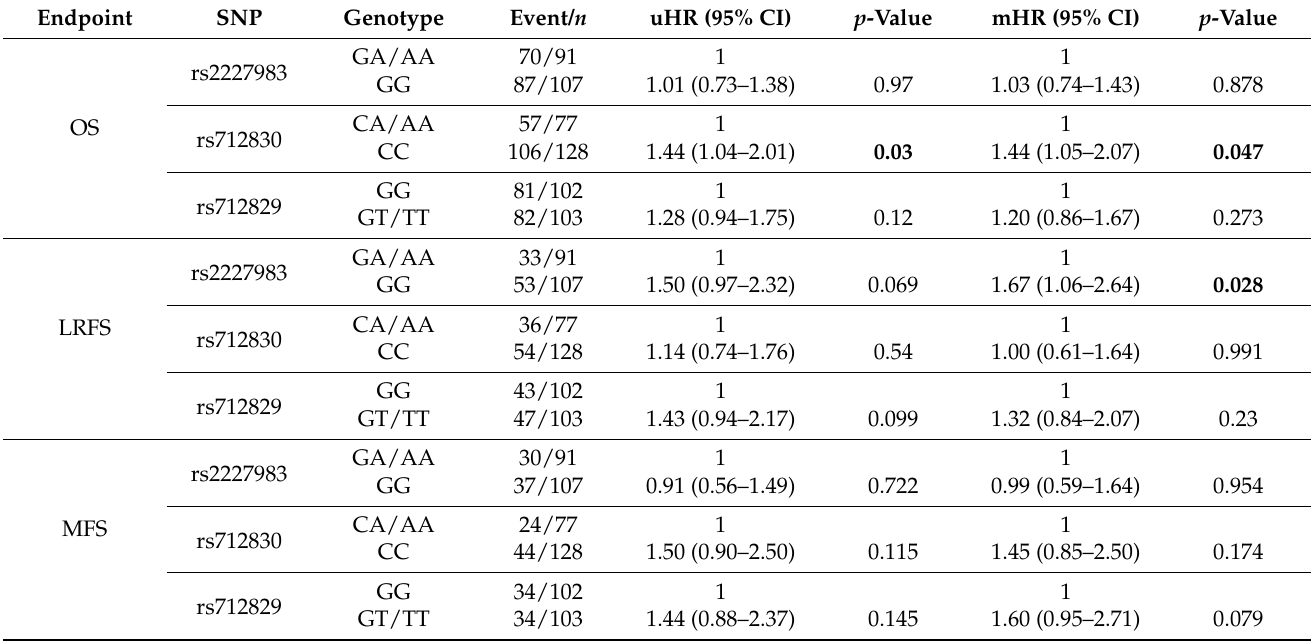
Table 3. Survival analysis according to individual SNPs in the subset treated with curative